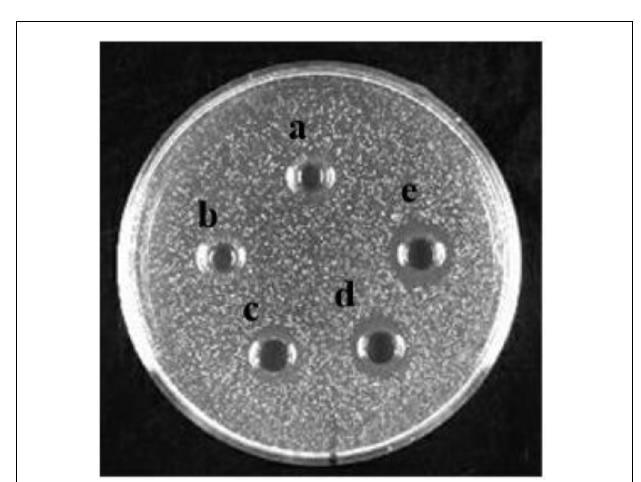
FIGURE 1 | Phylogenetic tree based on the 16S rDNA sequences of strain J23.